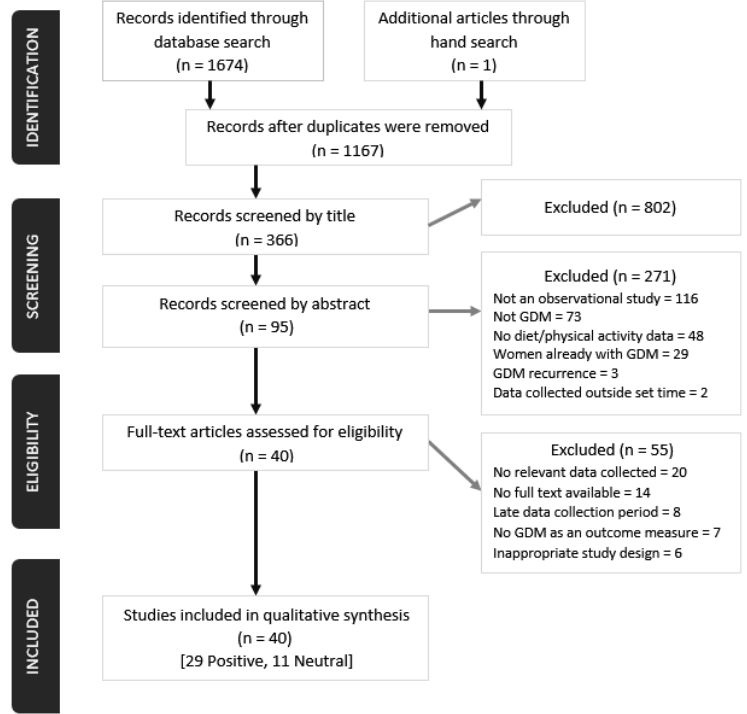
Figure 1. PRISMA flow diagram of screening, selection process and inclusion of studies.